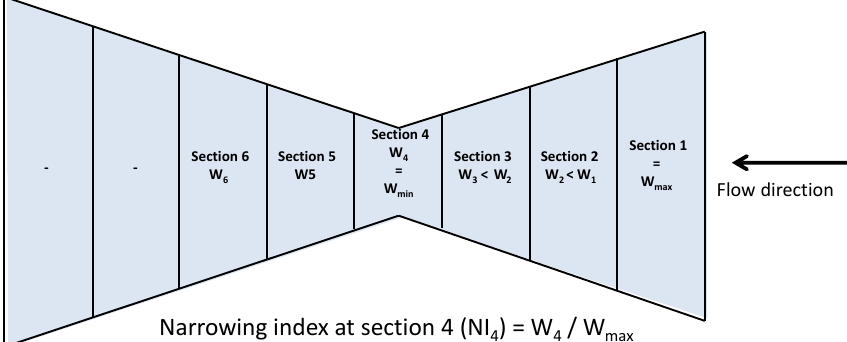
Figure 4. Approach used to calculate the narrowing index, dividing the section’s width ( W ) by the upstream maximum width ( W max ) .